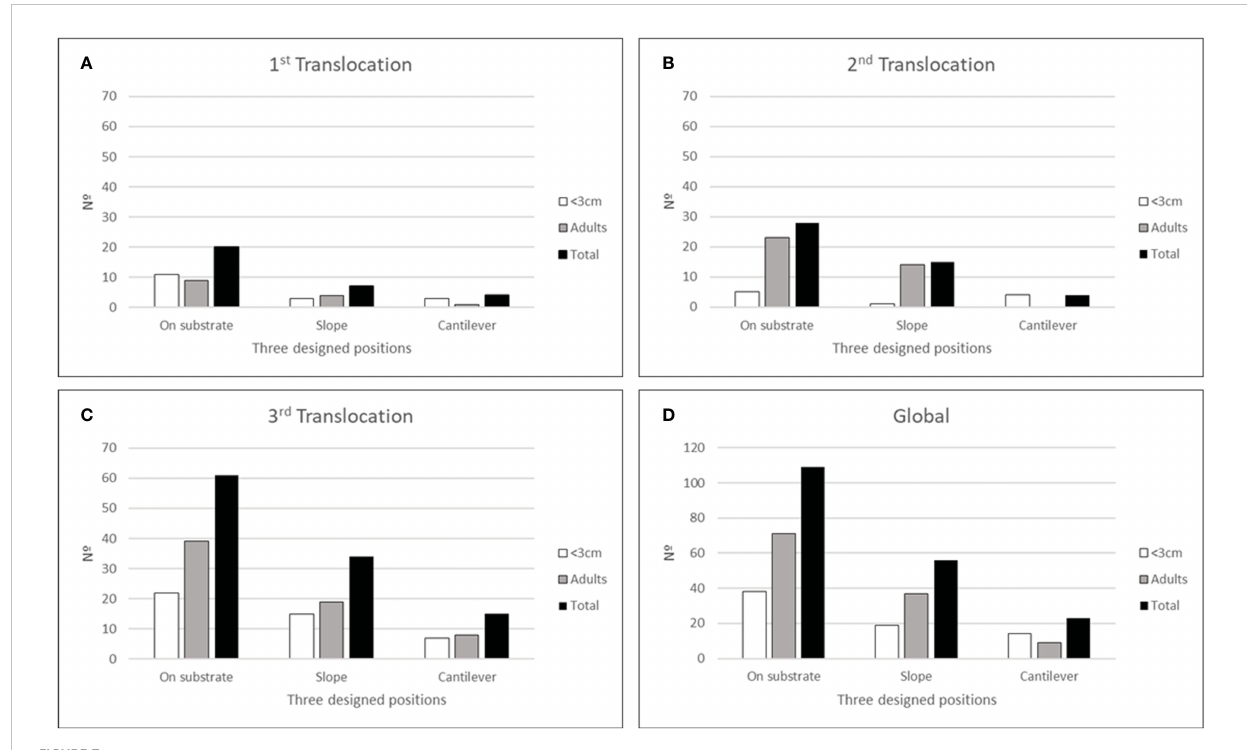
FIGURE 7 Number of individuals (<3cm, adults and total) settled on the three different treatments used (on substrate, slope, and cantilever). (A) fi rst translocation; (B) second translocation; (C) third translocation; (D) the whole number of individuals after the three translocation events.